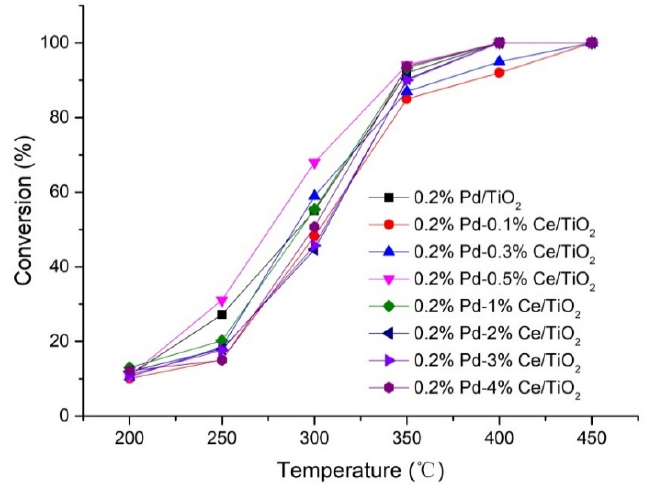
Figure 8. E ff ect of Ce loading on the catalytic oxidation of CB of 0.2% Pd / TiO 2 . CB concentration = Figure 8. Effect of Ce loading on the catalytic oxidation of CB of 0.2% Pd/TiO 2 . CB concentration = 2500 mg / m 3 ; GHSV = 30,000 h − 1 ; catalyst amount = 2 2500 mg/m 3 ; GHSV = 30,000 h −1 ; catalyst amount = 2 g.